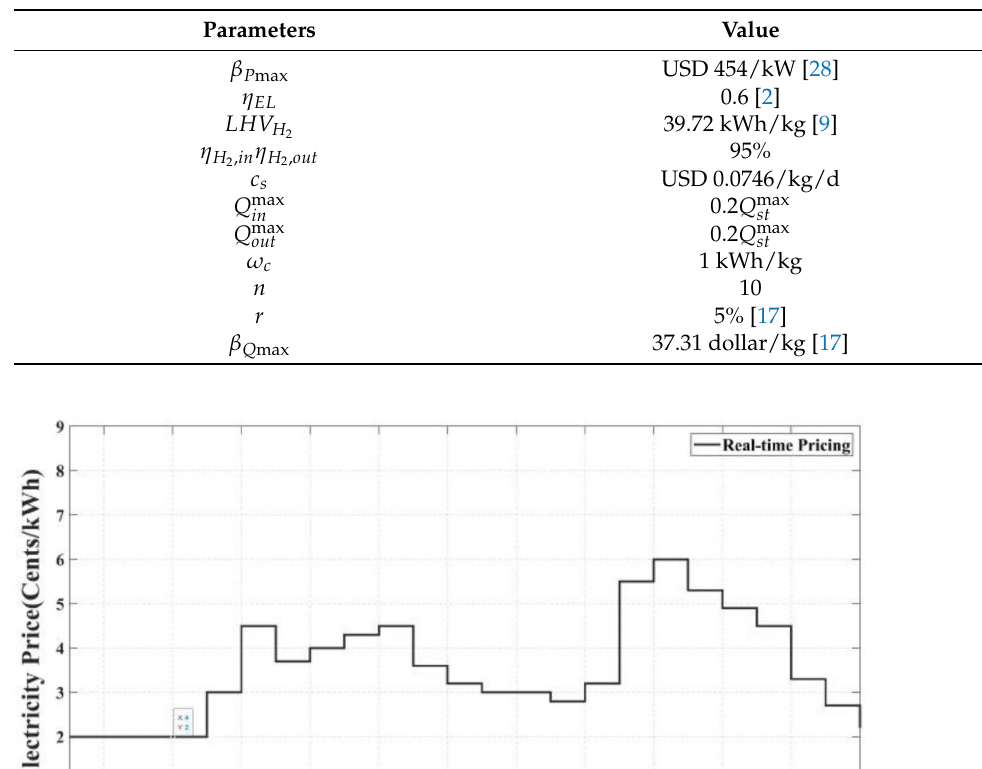
Table 3. Necessary parameters for capacity configuration.